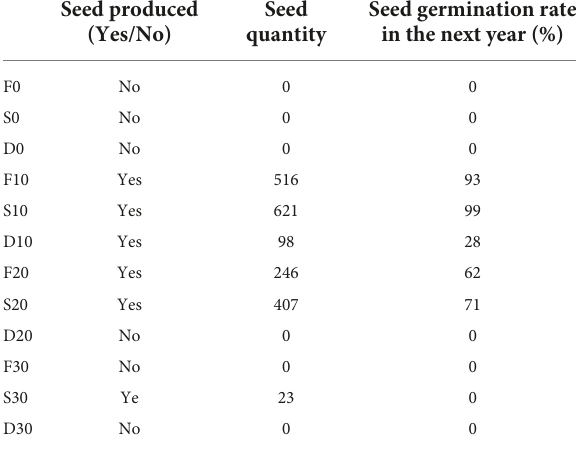
TABLE 3 Seed production of S. salsa subjected to water [long-term flooding (5–15 cm, F), periodic flooding (0–10 cm, S), and long-term drought (drought to saturated, D)] and salt treatment (0, 10, 20, and 30 g/kg). Seed produced Seed Seed germination rate (Yes/No) quantity in the next year